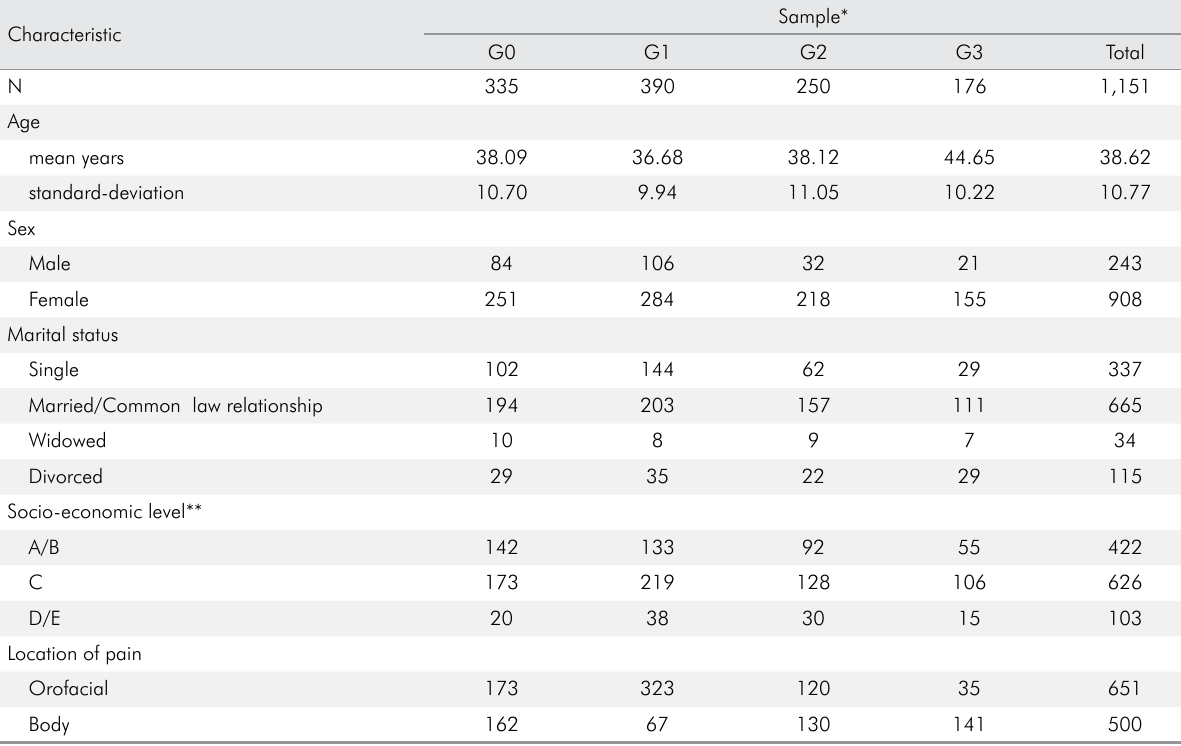
Table 2. Characteristics of participants according to group (n).